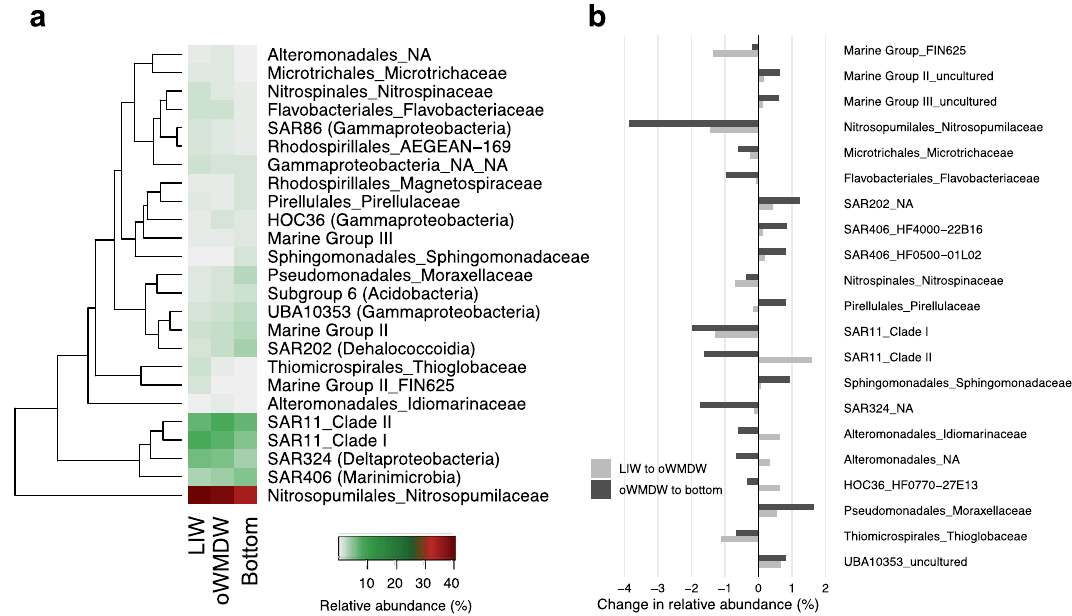
Figure 2. Composition of the meso- and bathypelagic prokaryotic communities. ( a ) Contribution of prokaryotic families to the community in the different water masses. Families that contribute ≥ 0.8% in at least one water mass are shown. Phylotypes are ordered according to the hierarchical clustering based on Bray–Curtis dissimilarity index using the ‘heatmap’ function in the ‘gplot’ package of R. ( b ) Phylotypes at family level that change their contribution ≥ 0.5% among the different water masses. Change between LIW and oWMDW in light grey and change between oWMDW and bottom in dark grey. Legends indicate Order_Family. NA: not